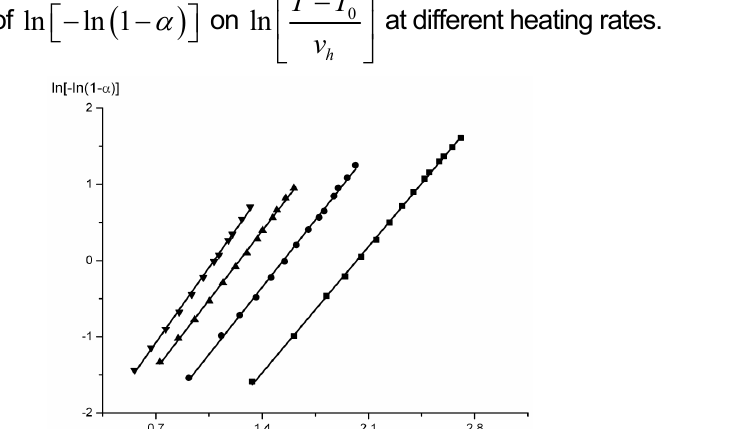
Figure 4 – Dependence of